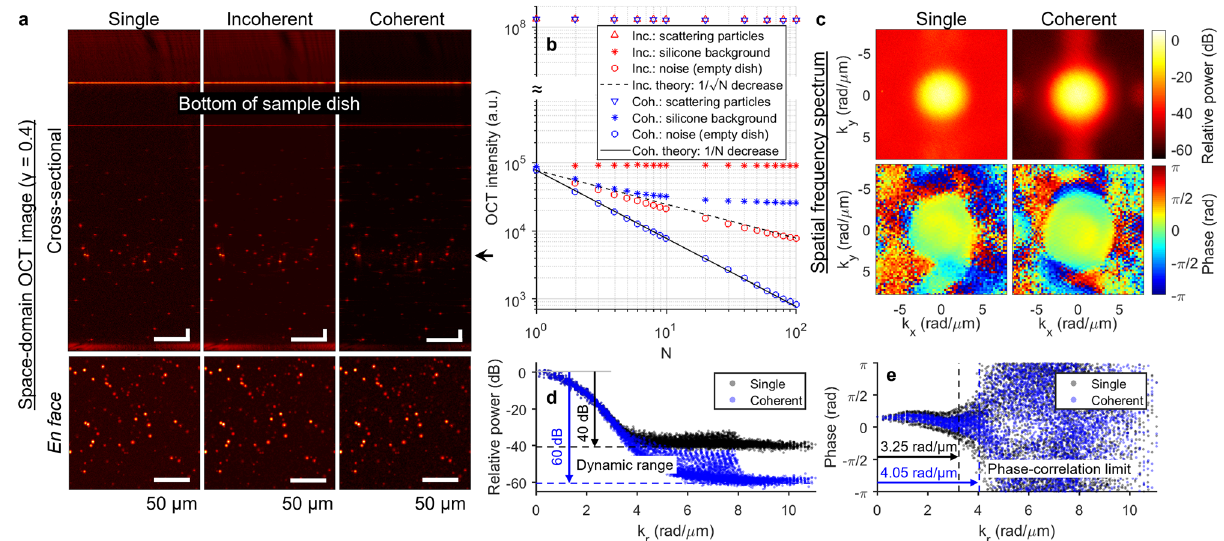
Figure 2. Coherent-average noise suppression with 100 acquisitions in silicone phantom. ( a ) Single-shot, incoherent- and coherent-average OCT images (same colormap range). En face images correspond to focal plane, indicated by arrow. Scale bar, 50 µm. ( b ) OCT intensity of scattering particles, silicone background, and noise as a function of N for incoherent (red) and coherent (blue) average. Noise intensity was obtained from the “noise image” of an empty sample dish (see “Methods”), at the same pixel depth as the focal plane of the phantom images. ( c ) Power and phase of single-shot and coherent-average images in transverse spatial-frequency domain (with spatial frequencies k x and k y ). Phase spectrum was obtained from the Fourier transform of a windowed region around a single particle. ( d ) Power spectrum in ( c ) plotted as a function of radial transverse spatial frequency k r . Dotted line indicates noise floor obtained from power spectrum of the noise image. ( e ) Phase spectrum in ( c ) plotted as a function of k r . Dotted line indicates k r limit beyond which phase becomes decorrelated (local standard deviation > 0.2 rad, see “Methods”). Supplementary Section VII investigates relations between N , DR and phase-correlation limit. Calculations of OCT intensity, DR, and phase- correlation limit are described in